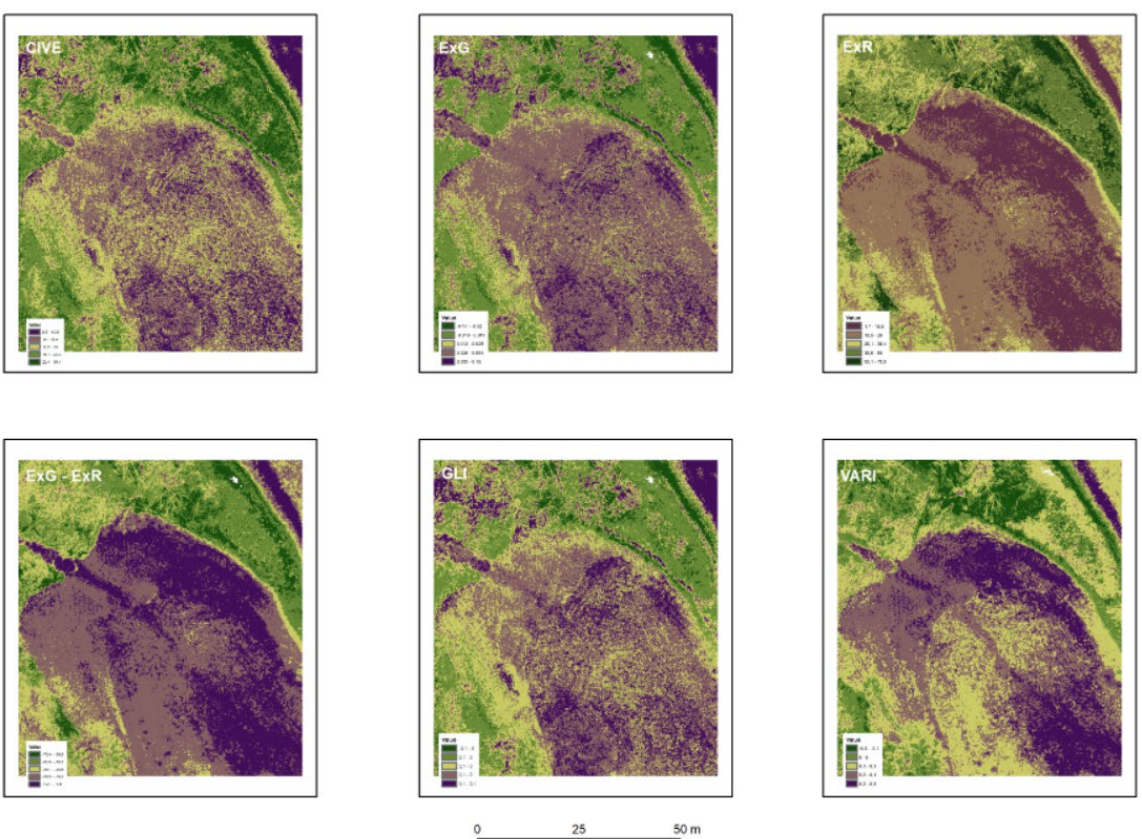
Figure 3. Spectral indices for the area on February 9, 2018, after low pass